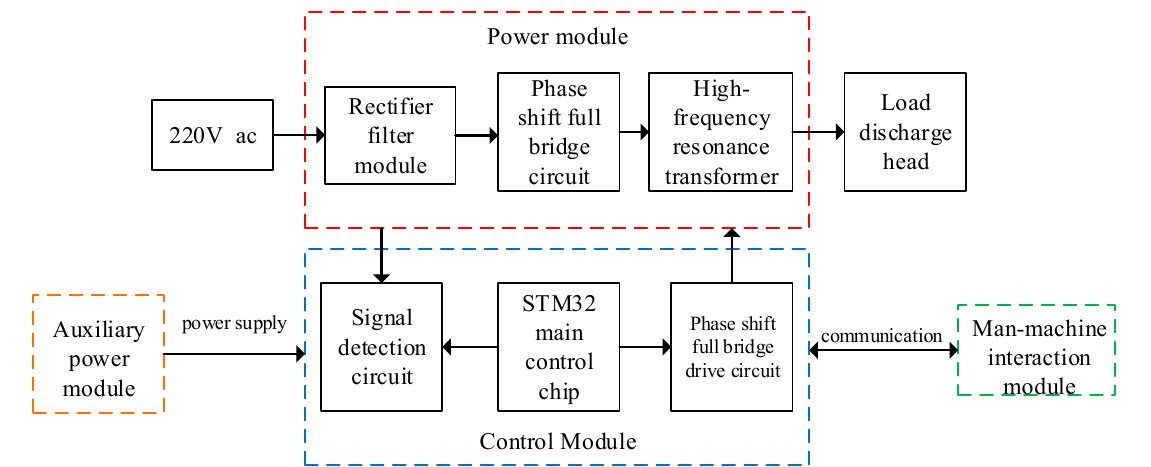
Figure 1. Structure of resonant power supply system for plasma cleaning.